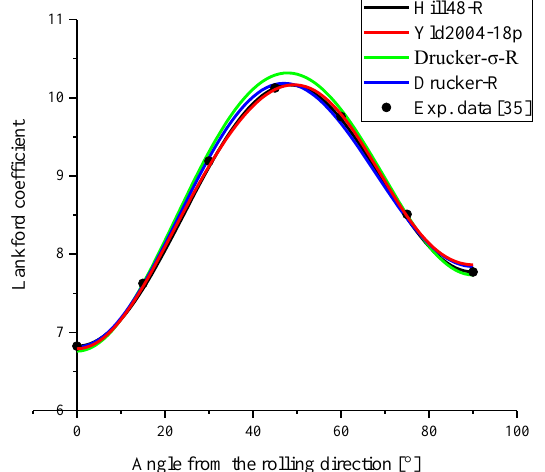
Figure 13. Predicted normalized tensile yield stresses and experimental (virtual) data. Metals 2019 , 9 , x FOR PEER REVIEW